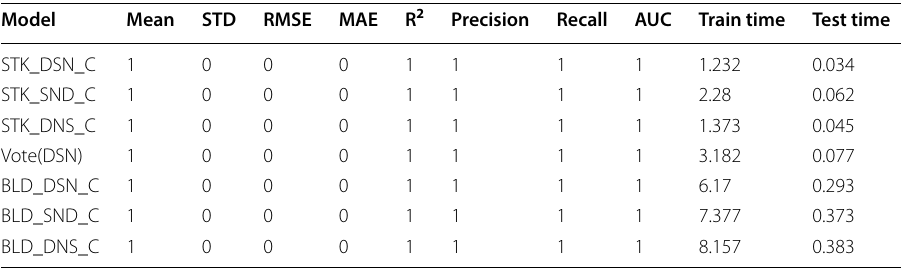
Table 20 Stacking and blending ensemble classifiers error metrics result on NYSE dataset Model